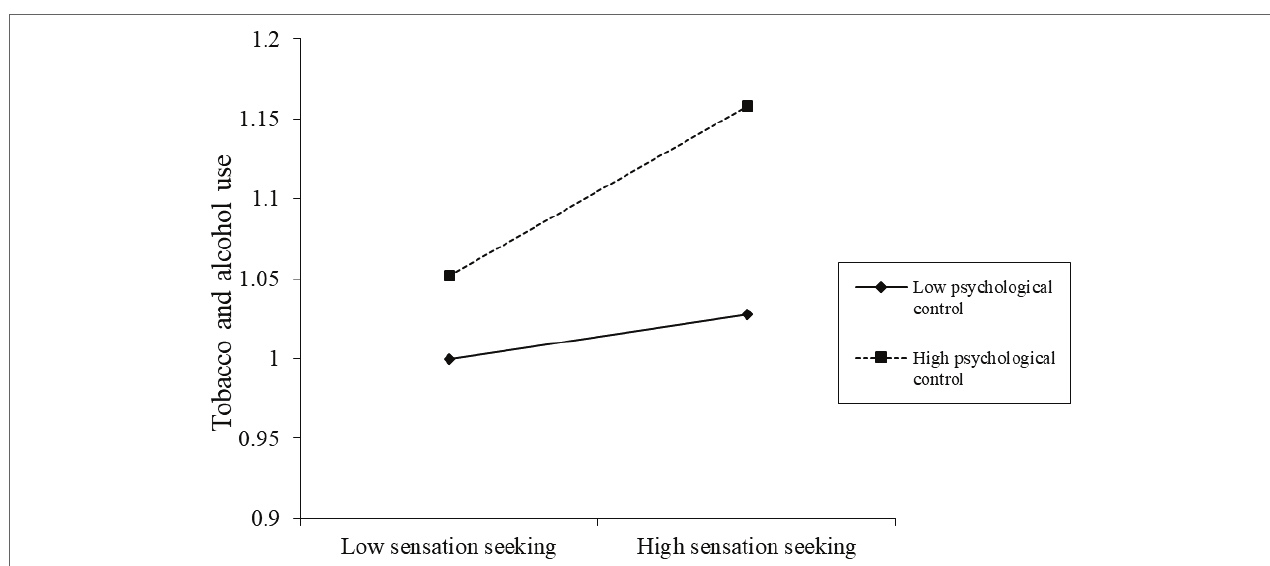
FIGURE 1 | The moderating effect of psychological control on the relationship between sensation seeking and the tobacco and alcohol use.